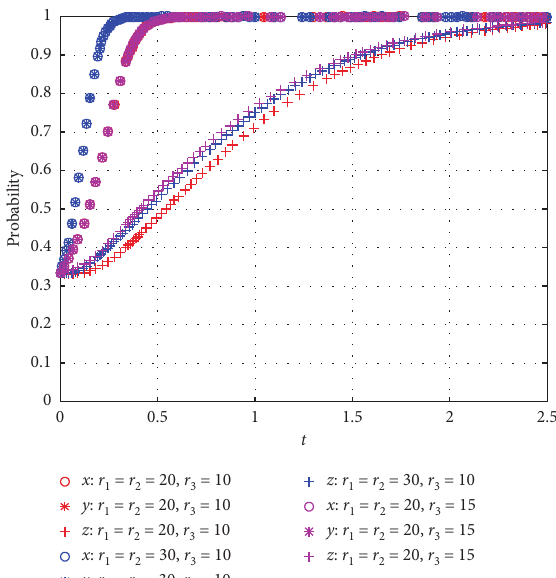
Figure 6: Evolution paths of scenario 4 under different benefits.